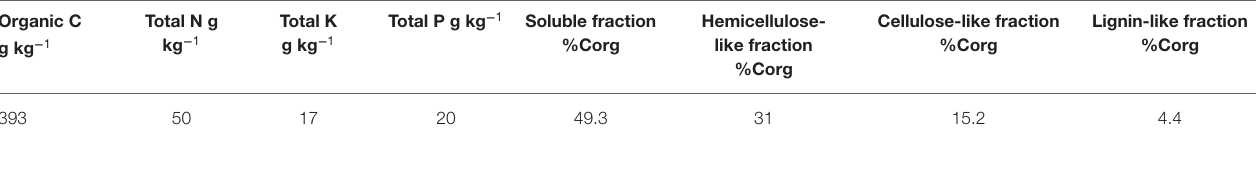
TABLE 1 | Chemical characteristics of frass (data from Houben et al., 2020). Organic